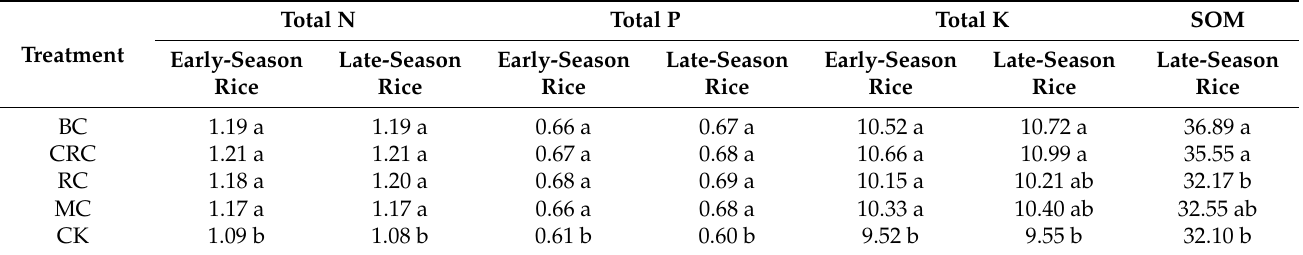
Table 5. The total N, P, K, and SOM under different organic material treatments in 2018 (g kg − 1 ). Total N Total P Total K SOM Treatment